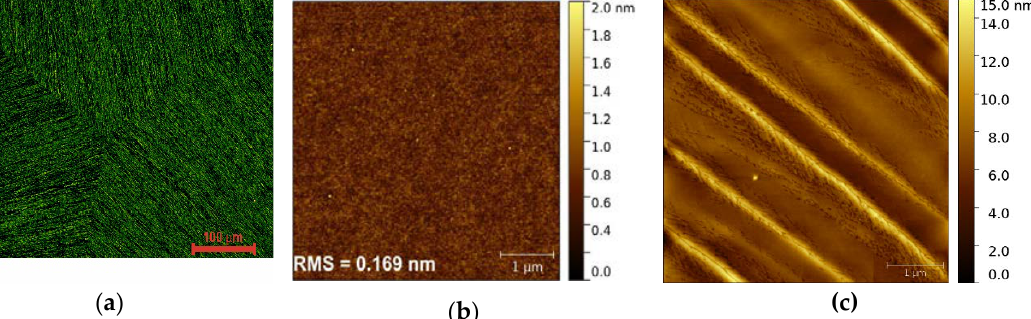
Figure A2. ( a ) Dark-field optical microscopy image of a poly-Ge surface annealed at T peak = 790 °C. Atomic force microscopy (AFM) scans of ( b ) an as-deposited a-Ge film and ( c ) a poly-Ge film corresponding to the image in ( a ).